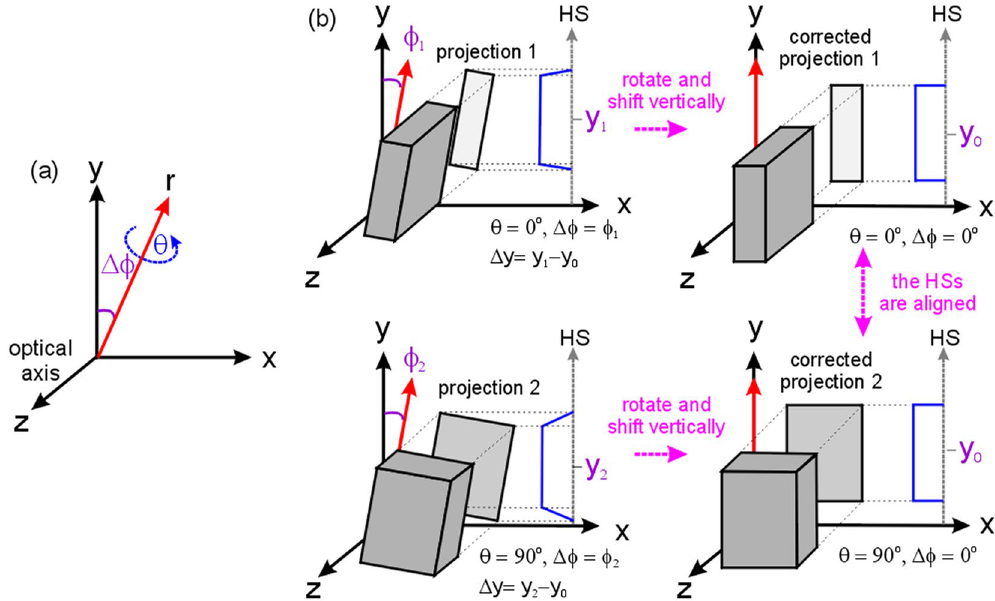
Figure 2. Method of vertical shift and rotational axis tilt corrections. ( a ) Spatial parameter definition. ( b ) Method for correcting two raw projections, which are obtained from different azimuthal angles ( θ = 0° and 90°), with different rotational axis tilts ( Δ φ = φ 1 and φ 2 ), and vertical shifts ( Δ y = y 1 − y 0 and y 2 − y 0 , where y 0 is an arbitrary reference position). The blue line profiles in ( b ) show the corresponding horizontal sums (HSs). If the vertical shift and rotational axis tilt of raw projections, which are captured from different azimuth angles, are well corrected, each of their HSs will be the same as shown in ( b